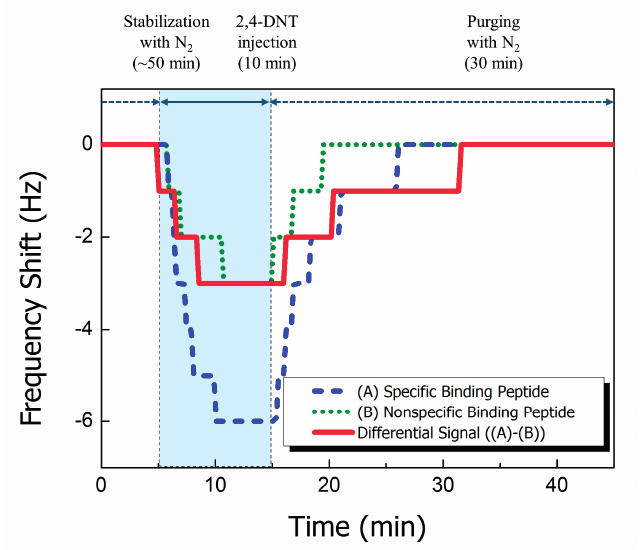
Figure 3. 2,4-DNT differential frequency responses (red solid line) between cantilevers functionalized with specific binding peptide receptors (blue dashed line) and nonspecific binding peptide receptors (green dotted line) in an environment containing 160 ppb